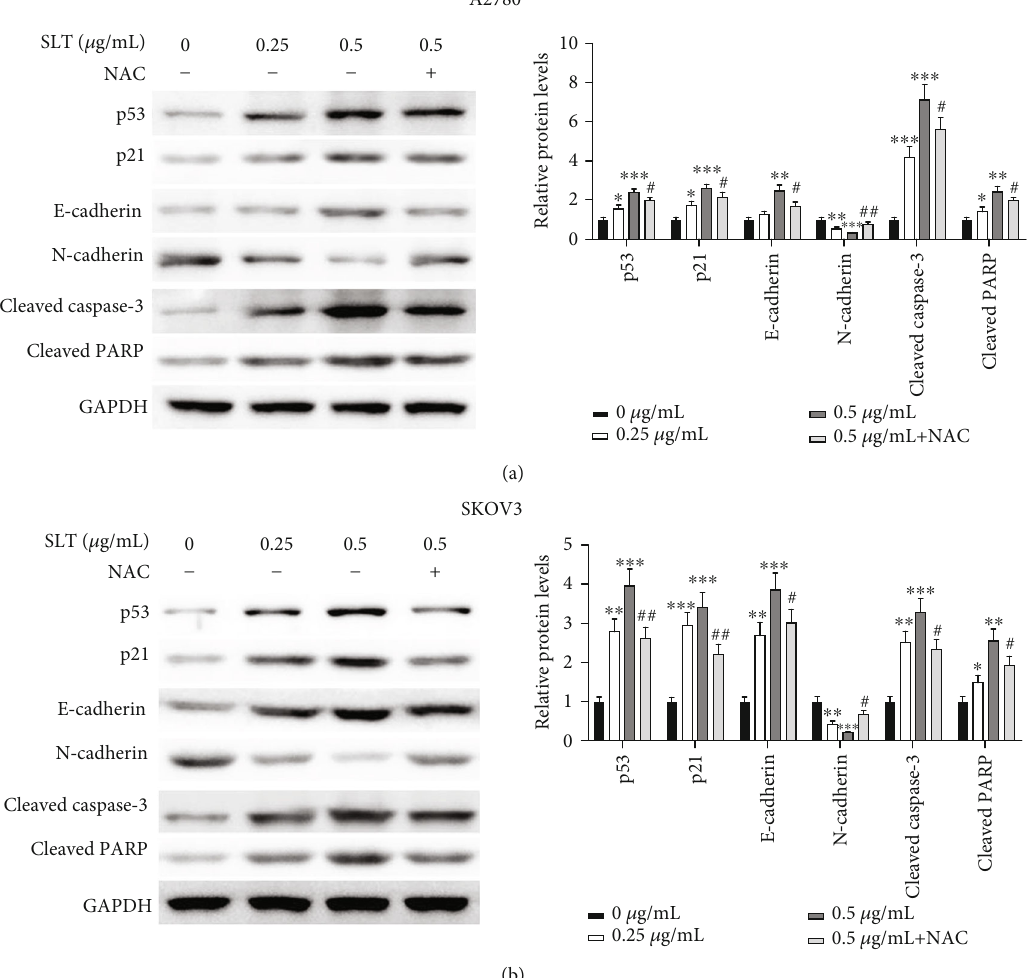
Figure 6: SLT induces the ROS/p53 pathway to regulate ovarian cancer cell proliferation, EMT, and apoptosis. (a) The e ff ects of SLT on the expression levels of p53, p21, E-cadherin, N-cadherin, cleaved caspase-3, and cleaved PARP in A2780 cells were evaluated via western blot assay. (b) The e ff ects of SLT on the expression levels of p53, p21, E-cadherin, N-cadherin, cleaved caspase-3, and cleaved PARP in SKOV3 cells were evaluated via western blot assay. The values were displayed as the mean ± SD . Representative results from three independent experiments were shown ( ∗ P < 0 : 05 , ∗∗ P < 0 : 01 , and ∗∗∗ P < 0 : 01 , compared with the control group; # P < 0 : 05 and ## P < 0 : 01 , compared with the 0.5 μ g/mL SLT